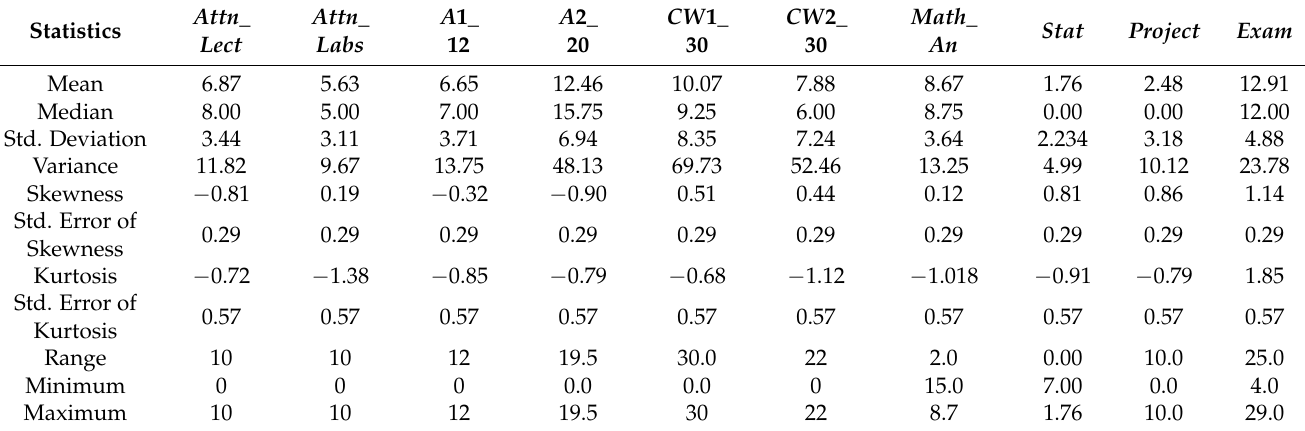
Table 2. Descriptive statistics of the initial predictors and the target